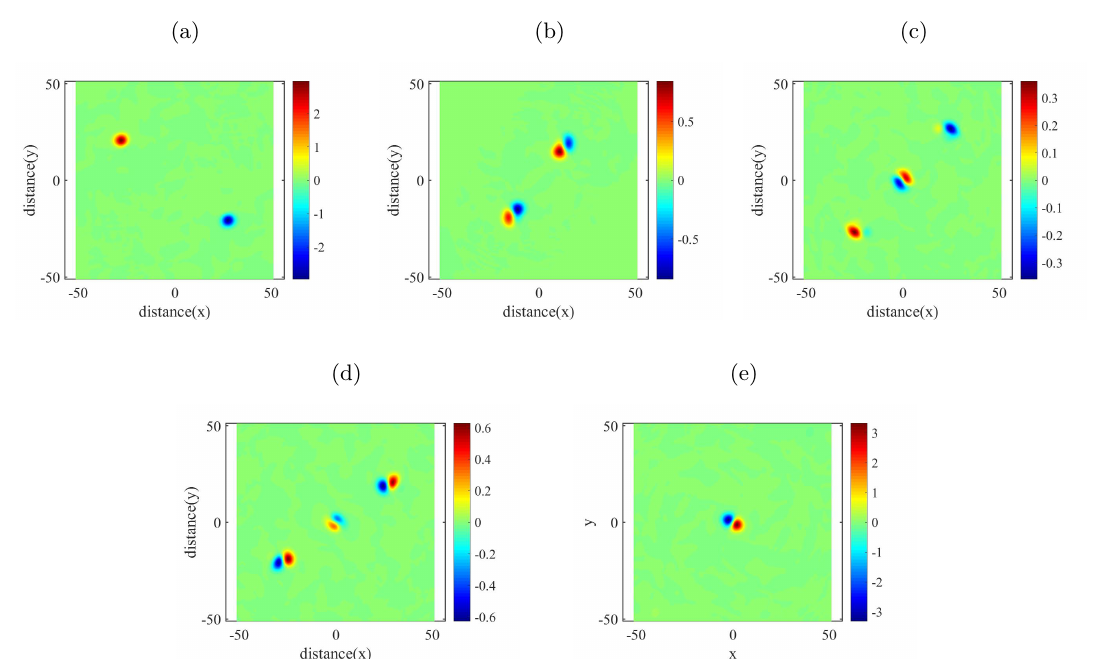
Figure 15 . Different end-states for the non-head-on collisions used to collate the data in figure 14, the color represents the charge density. The initial data for these plots are: (a) the impact parameter is 9 . 0 and the initial velocity is 0.10, (b) the impact parameter is 13 . 0 and the initial velocity is 0.09, (c) the impact parameter is 9 . 8 and initial velocity is 0.18, (d) the impact parameter is 9 . 0 and the initial velocity is 0.20, (e) the impact parameter is 11 . 80 and the initial velocity is 0.142.